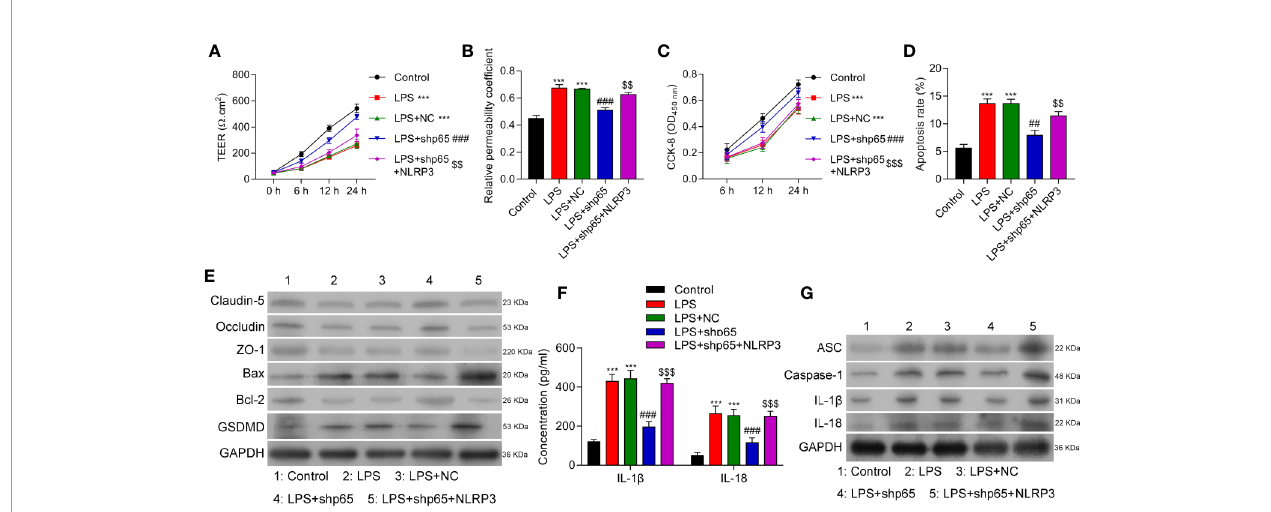
FIGURE 5 | Overexpression of NLRP3 reversed the effects of p65 on in vitro BBB integrity,apoptosis, and in fl ammation in response to LPS. BMECs were transfected with the control vector (NC),NLRP3 or a combination ofshp65 and NLRP3, followed by LPS stimulation.The BMECs were then co-cultured with astrocytes to establish an in vitro BBB model. (A) The TEER values ofmonolayer cells at 0, 6, 12, and 24 h were measured using a bioelectric impedance analyzer. (B) Trans-endothelial permeability assayswere performedto assess in vitro BBB integrity byusing the diffusion of 10 kDa FITC-dextran method. The relative permeability coef fi cient was determinedafter the Transwellexperiment. (C) Cell viability was analyzedusing theCCK-8 assay. (D) Quanti fi cation of cellapoptosis. (E) Western blot results for the levels of Claudin-5, Occludin, ZO-1, Bax, Bcl-2, and GSDMD. (F) The cell-freeconditioned culture medium was collectedand analyzed for IL-1 b and IL-18 levels via ELISA. (G) Western blotanalysisof pro-in fl ammatorycytokine (ASC, caspase-1, IL-1 b , andIL-18) levels. Results are expressed as the mean value ± SD of data obtained from three separate experiments. *** p < 0.001, compared with Control; ### p < 0.001, compared with LPS+NC; $$ p < 0.01 and $$$ p < 0.001 compared with LPS +